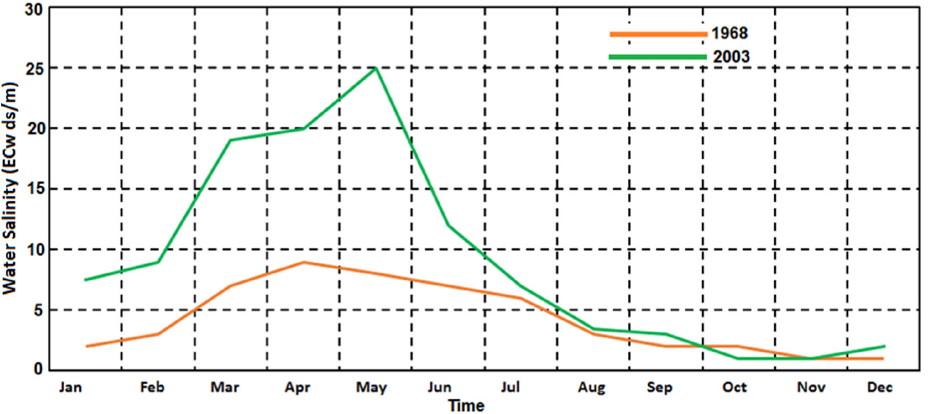
Figure 6. Water salinity density at the Passur-Mongla River site (1968–2003). (Based on data from Islam and Gnauck (65)).